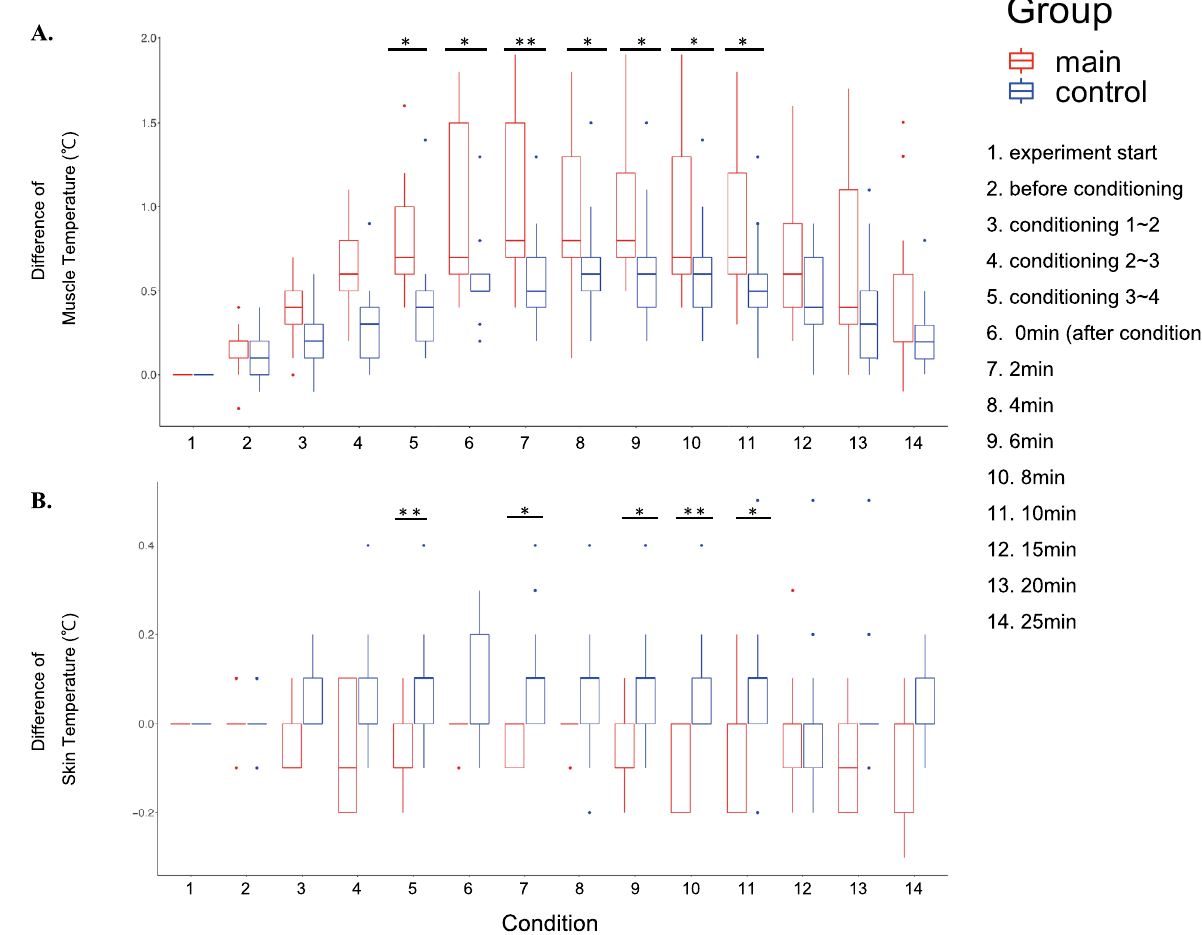
Figure 6. A time-course of the temperature of the finger flexor muscle at the forearm ( A ) and skin of the forearm ( B ) throughout a course of the experiment in the main group (with the plyometric activity in red) and control group (without the plyometric activity in blue). The x-axis indicates the conditions, each of which is indicated at the right box in the figure. *p < 0.05, **p <